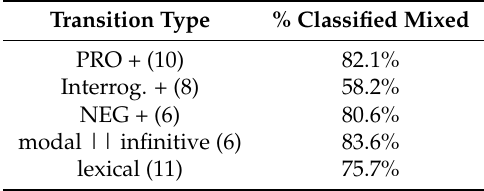
Table 5. Classification experiment; results for mixed stimuli ( N =